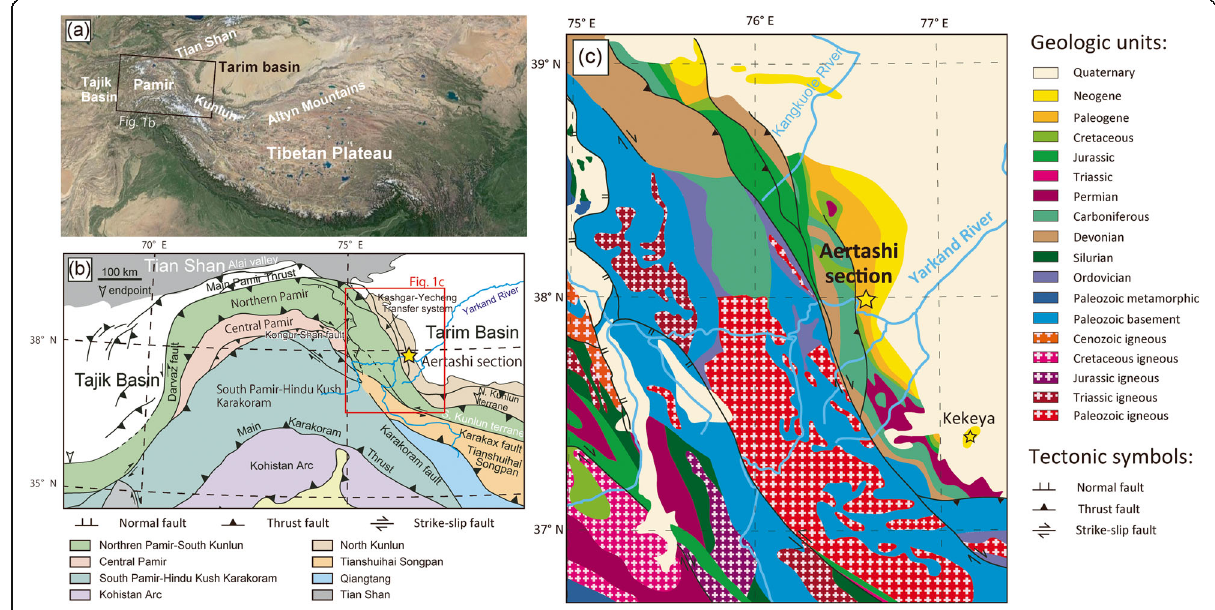
Fig. 1 Tectonic setting in this study. a Location of the Pamir (Google Earth). b Simplified tectonic setting of the Tarim Basin and surrounding areas (modified after Cowgill 2010). c Geological map of the eastern Pamir (after Robinson et al. 2007; Cowgill 2010; Cao et al.